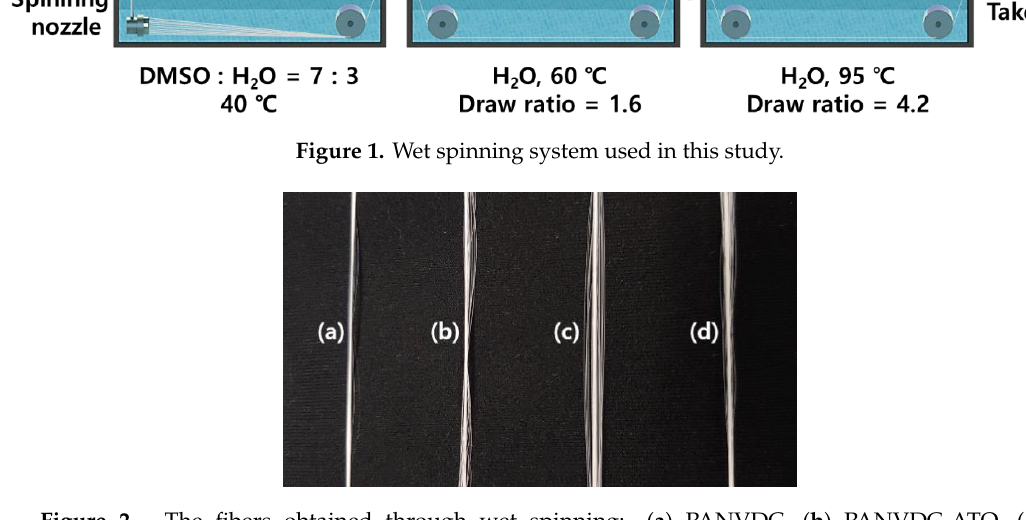
Figure 2. The fibers obtained through wet spinning: ( a ) PANVDC, ( b ) PANVDC-ATO, ( c ) PANVDC- ATO/ZHS, and ( d ) PANVDC-ZHS fiber.